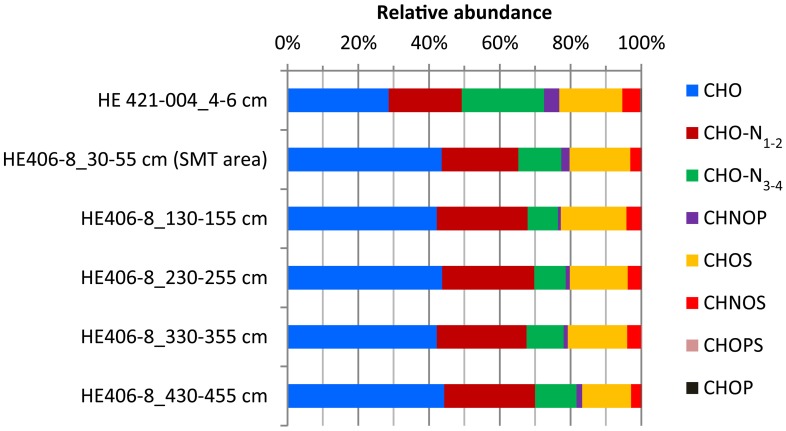
Depth-wise relative abundance distribution of intensities of molecular formulae groups classified based solely on heteroatoms (N, S, and P) contents. Surface sediment samples (4–6 cm) are obtained from core HE421-004. Deeper sediments samples (30–455 cm) are obtained from core HE 406-008.